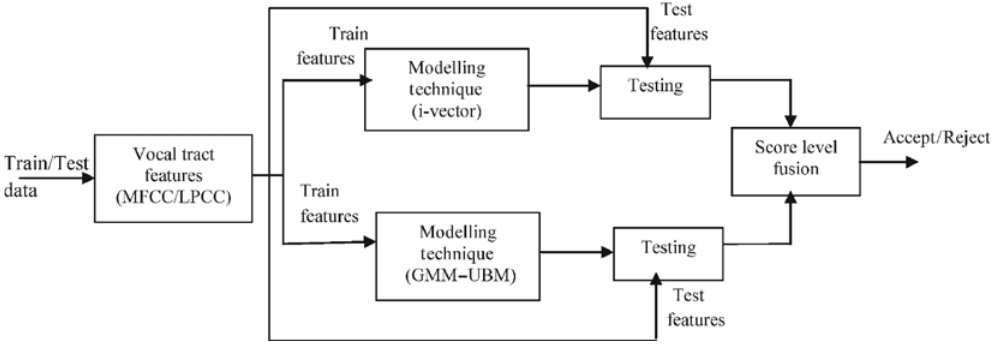
Figure 4: Block Diagram of Proposed Combined Modeling. Table 9: Performance of the Speaker Verification System for Score-Level Fusion Using i-Vector and GMM–UBM Modeling Tech- niques for Limited Data Condition in the NIST 2003